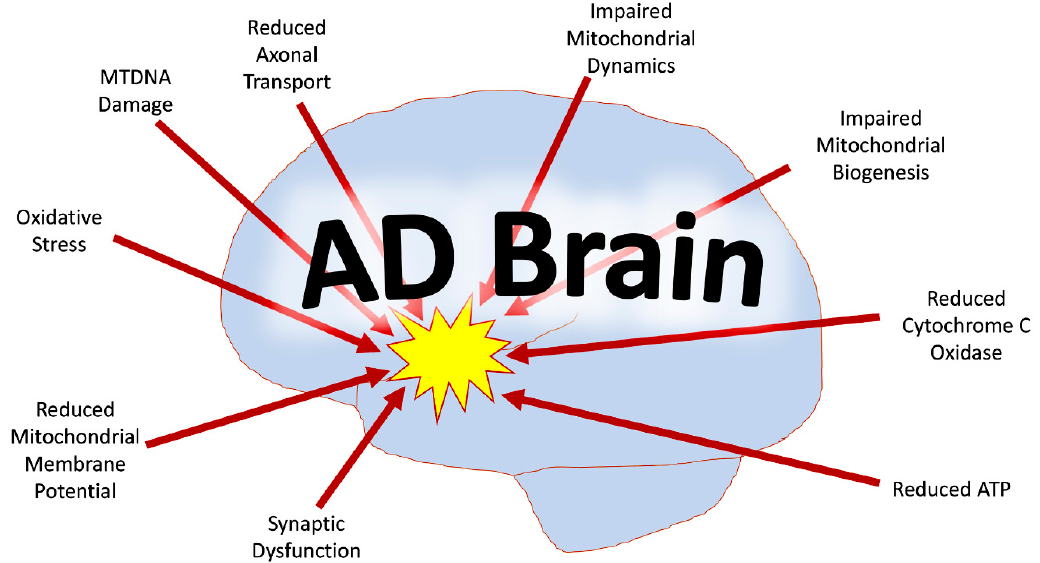
Figure 1. Mitochondrial abnormalities in the Alzheimer’s disease (AD) brain. Mitochondrial dysfunction in the AD brain includes mtDNA damage, reduced mtDNA copies, increased oxidative damage, reduced mitochondrial axonal transport, reduced mitochondrial membrane potential, dysfunctional mtDNA expression, rise in mtDNA mutations, impaired mitochondrial dynamics, and defective mitochondrial